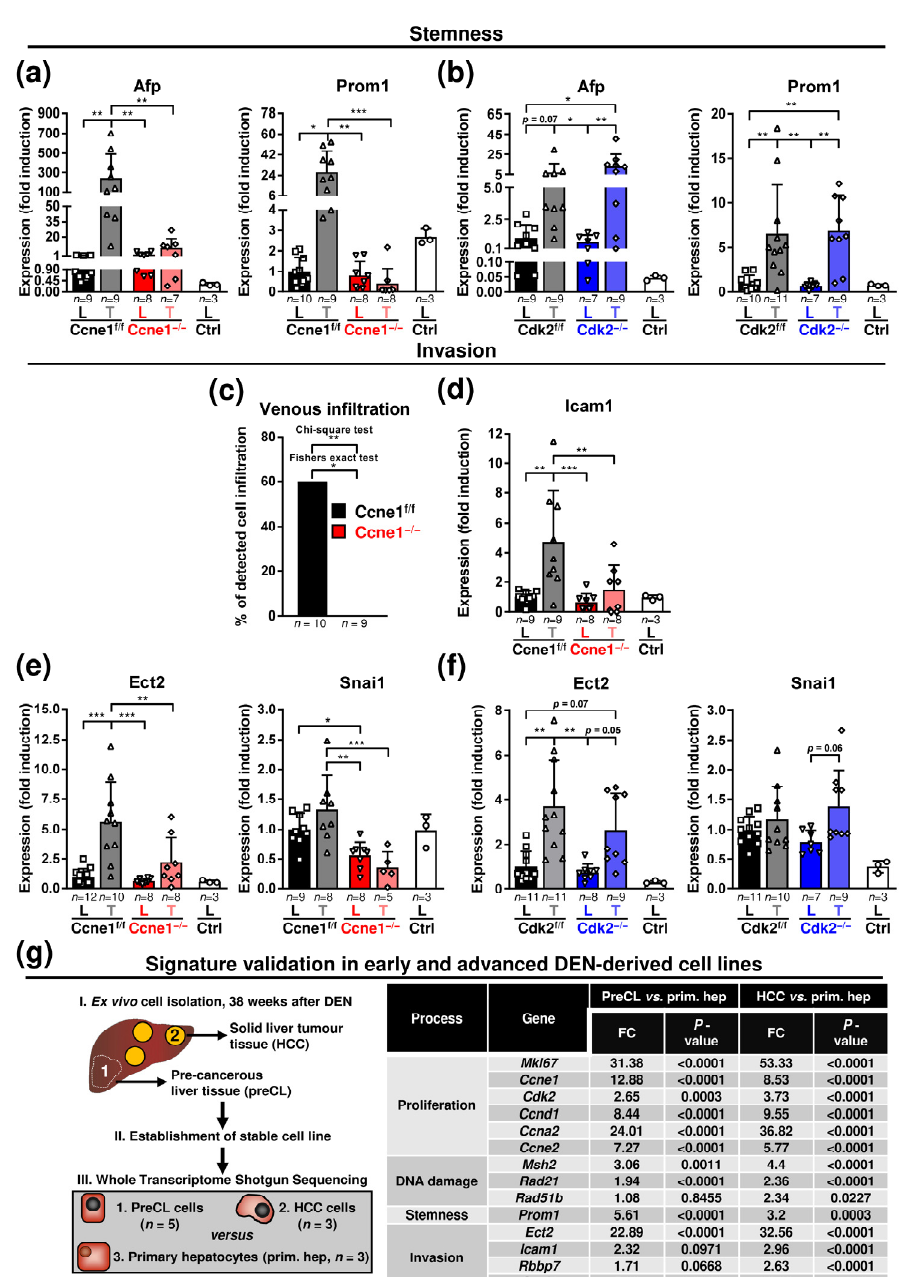
as loading control. Red arrows: reduced phosphorylation of unknown substrates specifically in tumorous tissues of Ccne1 − / − animals. ( d , e ) Gene expression analysis of Mut-S homologue 2 ( Msh2 ), Rad51b and Rad21 in ( d ) CcnE1 f/f and CcnE1 − / − or ( e ) Cdk2 f/f and Cdk2 − / − animals. Ctrl: livers of untreated wildtype mice. Normalised expression levels were calculated as fold induction in comparison to DEN-treated control livers. Corresponding signalling pathways of the target genes are indicated in the headings. Sample sizes are indicated within diagrams. Data are expressed as mean ± SD. *: p < 0.05; **: p < 0.005; ***: p < 0.001.